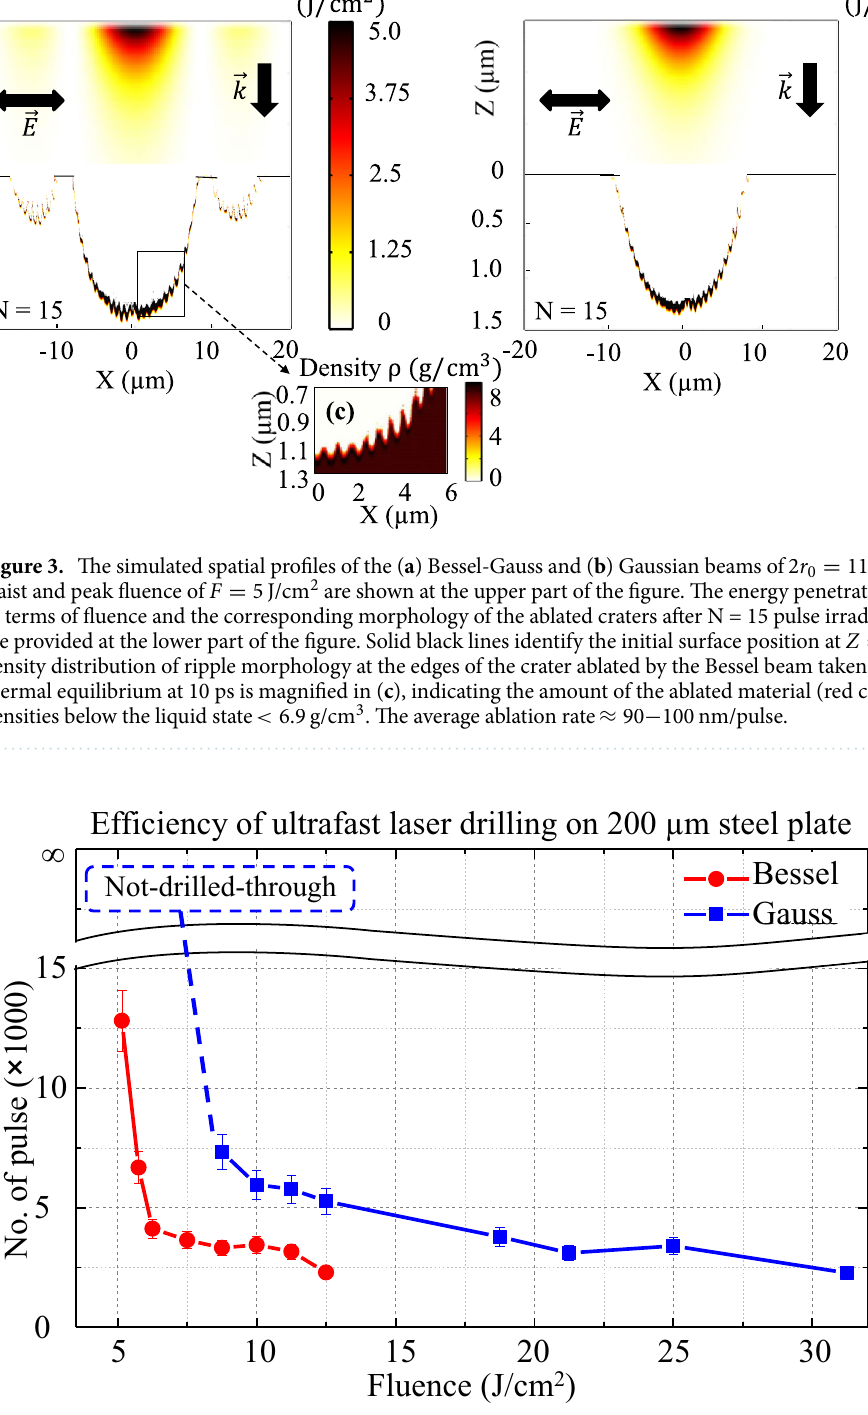
Figure 4. Efficiency comparison of the ultrafast laser drilling through the 200 μm thick steel plate in the Bessel and Gauss modes. The results are presented as the overall number of pulses necessary to pierce through the plate as a function of the pulse fluence ( F ). A smaller number of pulses is generally required to drill through the plate upon increasing the laser fluence. The use of the Bessel beam resulted in a twofold drop of the required pulse number (red-curve) when comparing to the Gaussian beam (blue-curve) in the tested fluence range. Particularly, at the fluence below 8 J/cm 2 the Bessel beam was still able to drill through the plate while the Gaussian resulted in incomplete, blind channels (represented by an infinite number of